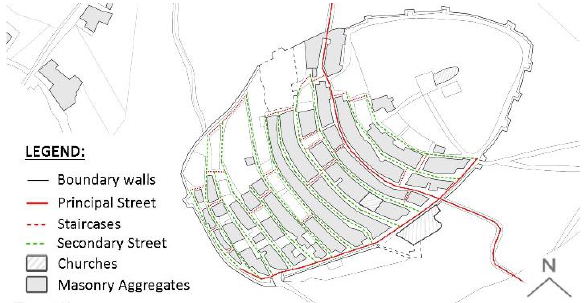
Figure 1. General organization of Structural Aggregates in